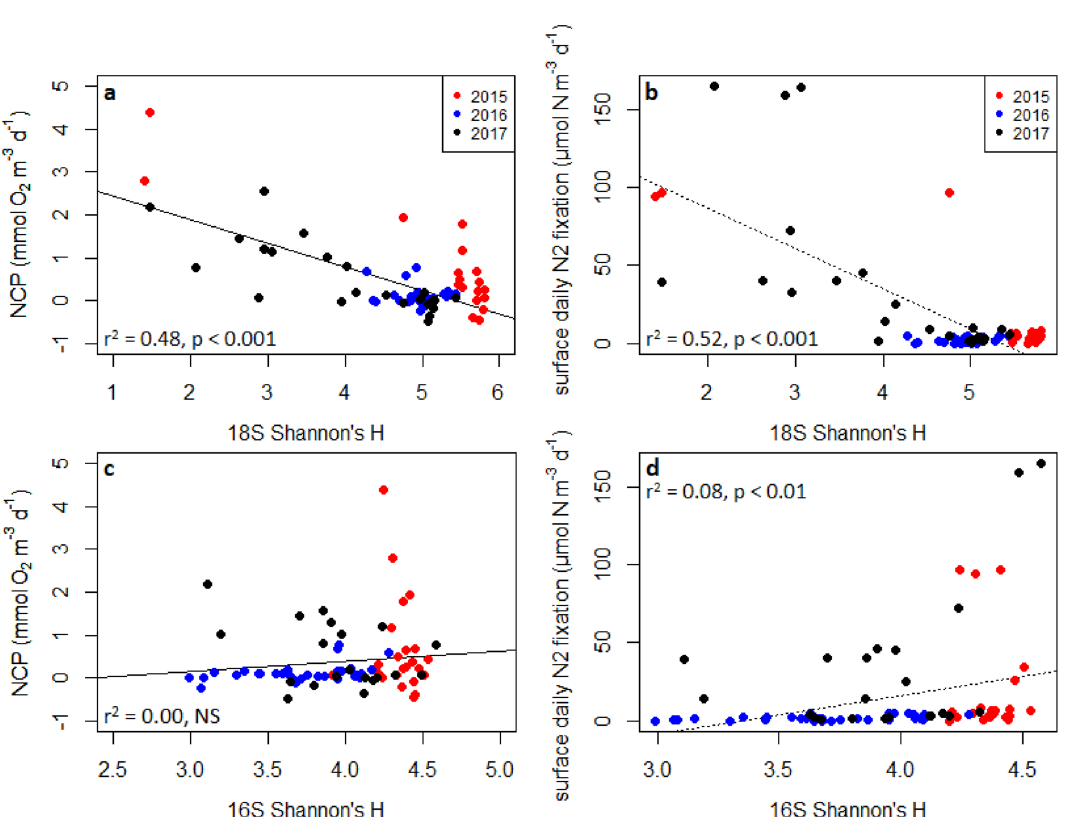
Figure 5. Linear regressions of ( a) NCP and ( b) N 2 fixation rates vs 18S Shannon’s H diversity. Linear regressions of ( c) NCP and ( d) N 2 fixation rates vs 16S Shannon’s H diversity. Significance and goodness-of-fit are displayed for each plot. All diversity metrics were calculated at the OTU level. Figure created in R 3.5.2 (https ://www.r-proje